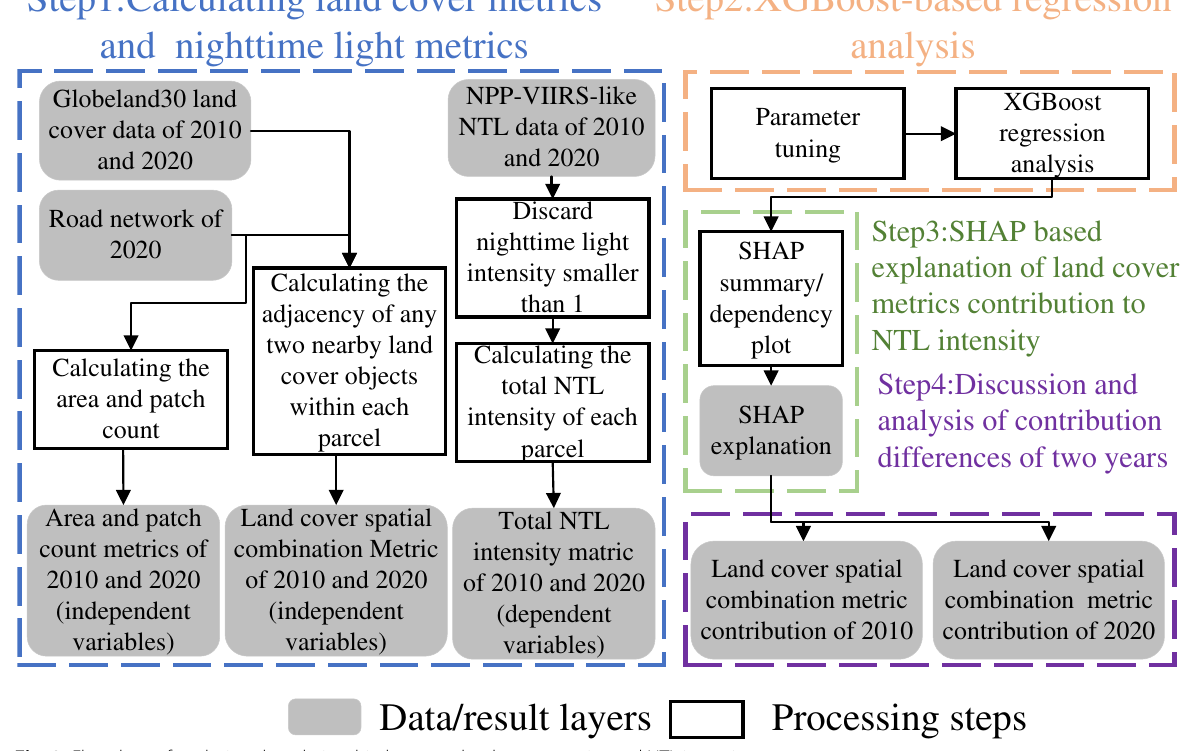
Fig. 2 Flowchart of analyzing the relationship between land cover metrics and NTL intensity